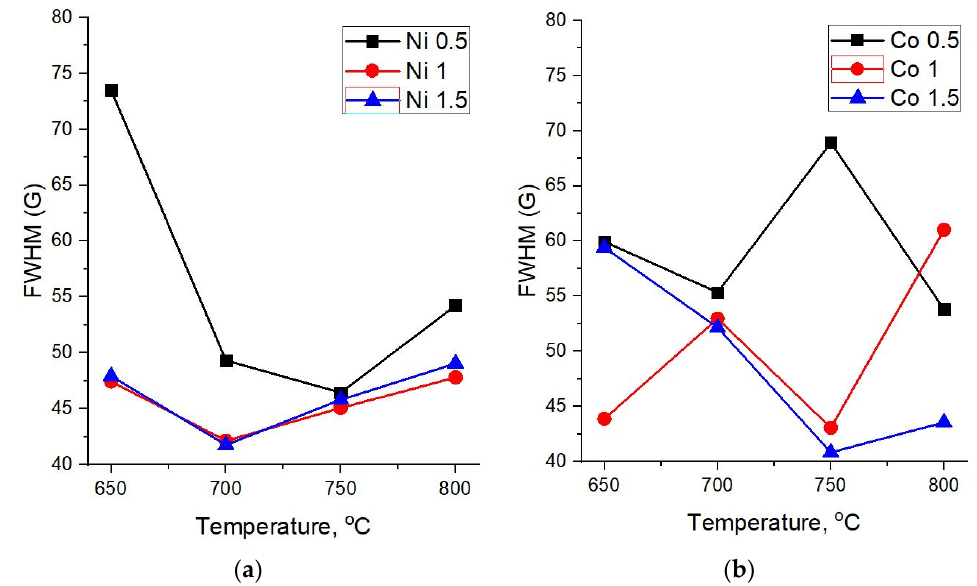
Figure 6. Dependence of the G peak width on the synthesis temperature of MWCNTs. ( a ) Ni and ( b ) Co catalysts. ( b ) Co